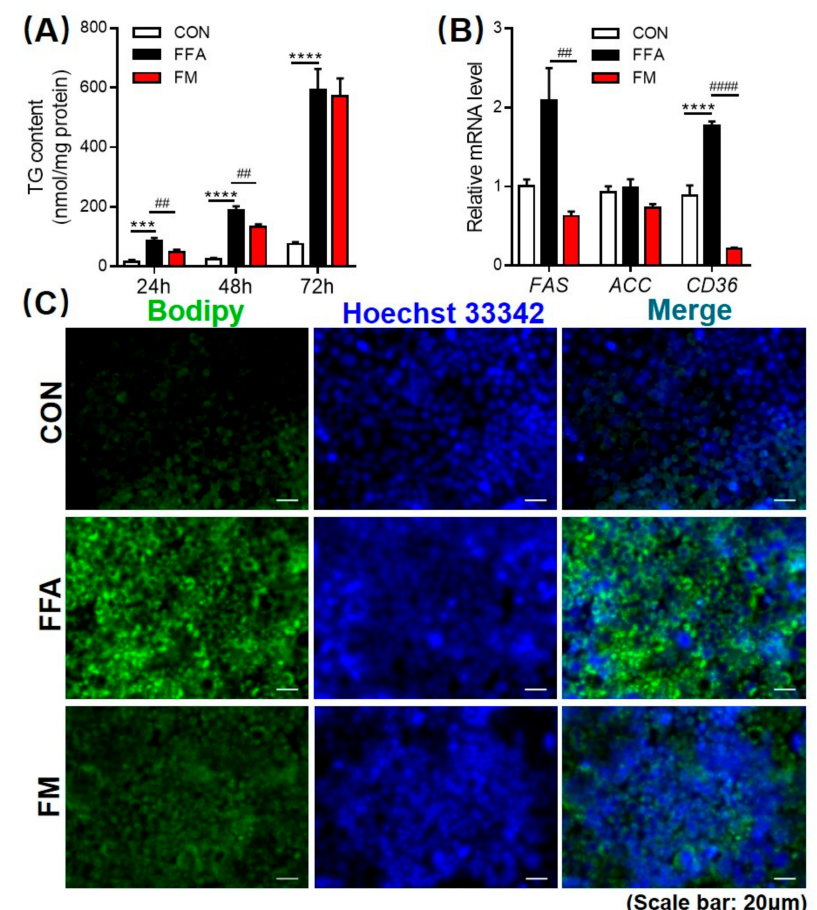
Figure 5. Melatonin alleviates lipid infiltration in L-02 cells by reducing lipogenesis gene expression. ( A ) Quantification of the intracellular triglyceride levels after melatonin treatment 24, 48, or 72 h. ( B ) The mRNA expression levels of fatty acid transport CD36 and lipogenic genes FAS and ACC were measured by real-time PCR. ( C ) BODIPY staining of L-02 cells that were treated with a 1 mM FFA mixture (oleic acid and palmitic acid at a molar ratio of 2:1) for 48 h and also treatment with 1 mM melatonin (FM) (scale: 50 µ m). Values are presented as the mean ± SEM. ( A – B , n = 6) * p < 0.05; ** p < 0.01; *** p < 0.001 compared with LD, # p < 0.05; ## p < 0.01; ### p < 0.001 compared with LL by one-way